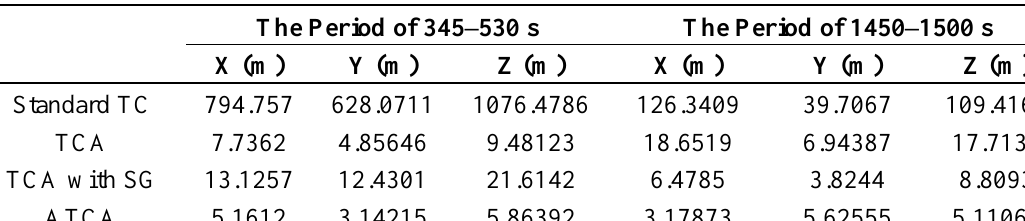
Table 6. RMS position error in the two periods.